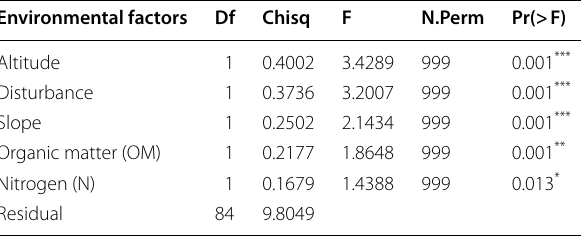
Table 4 Most influential environmental factors that affect the distribution of plants in Sele-Nono